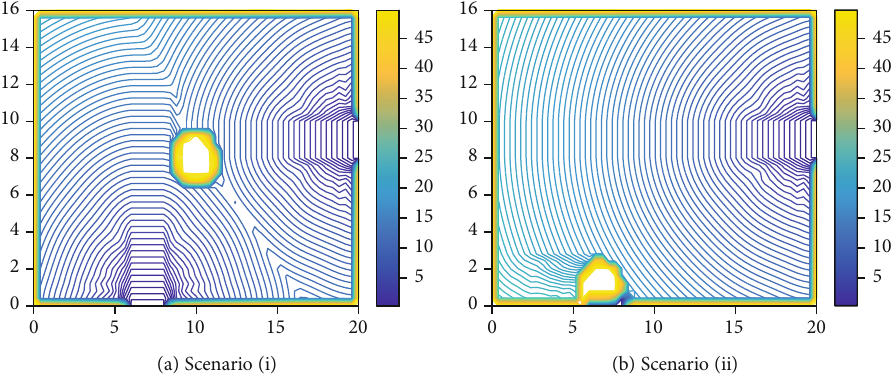
Figure 7: Contour plots of the dynamic potential (estimated remaining travel time) of 300 pedestrians in scenario (i) and scenario (ii) at t = 5 s